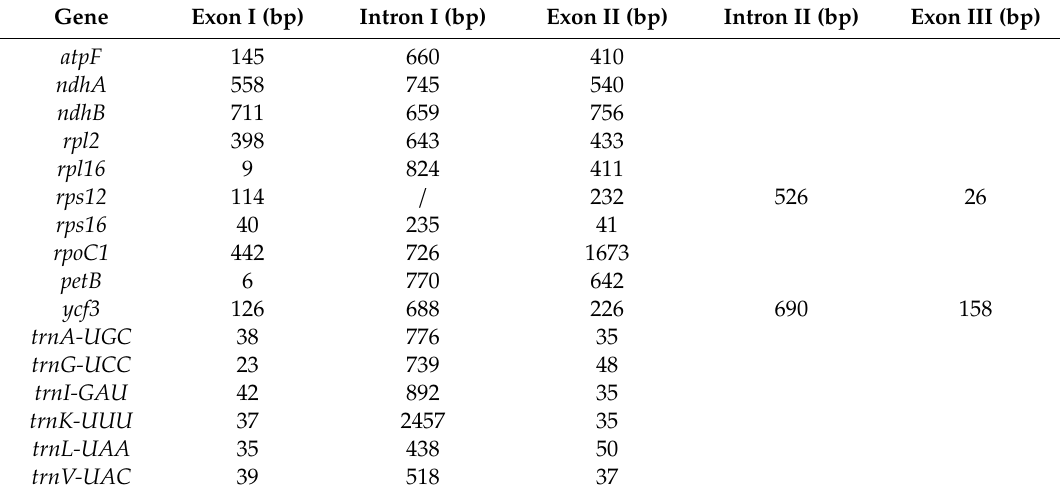
Table 2. Genes containing introns in the F. hodginsii cp genome.